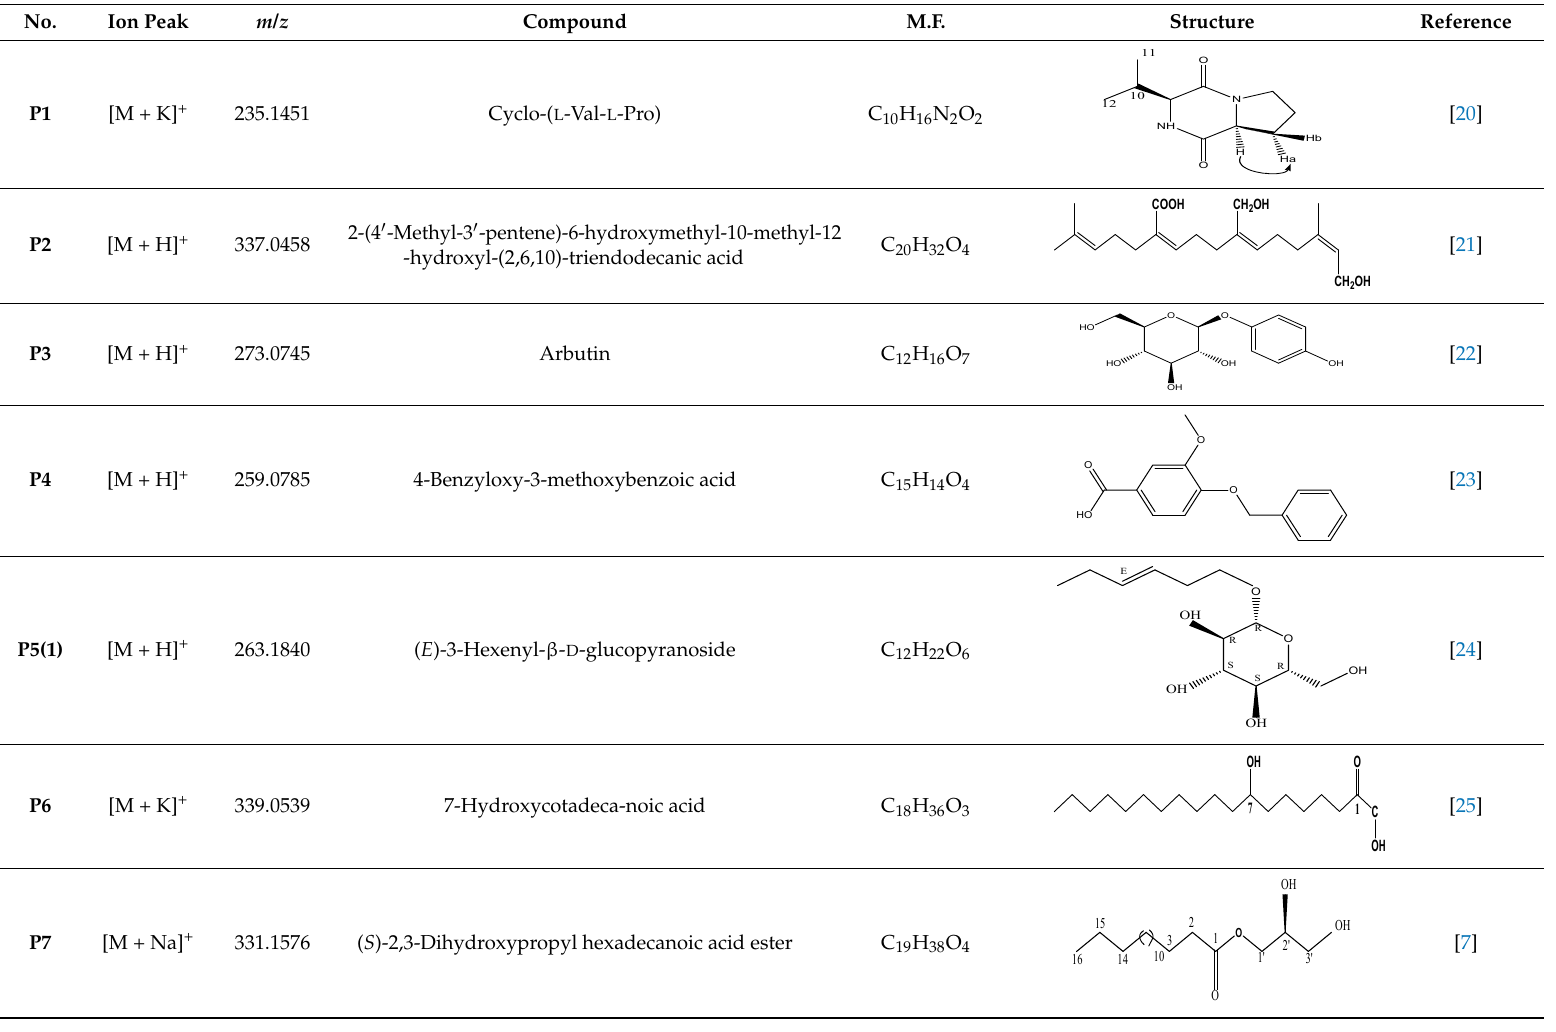
Table 3. Compounds identified from the water elution fraction (Fr.D1) of Periplaneta Americana (M.F.: molecular formula). No.